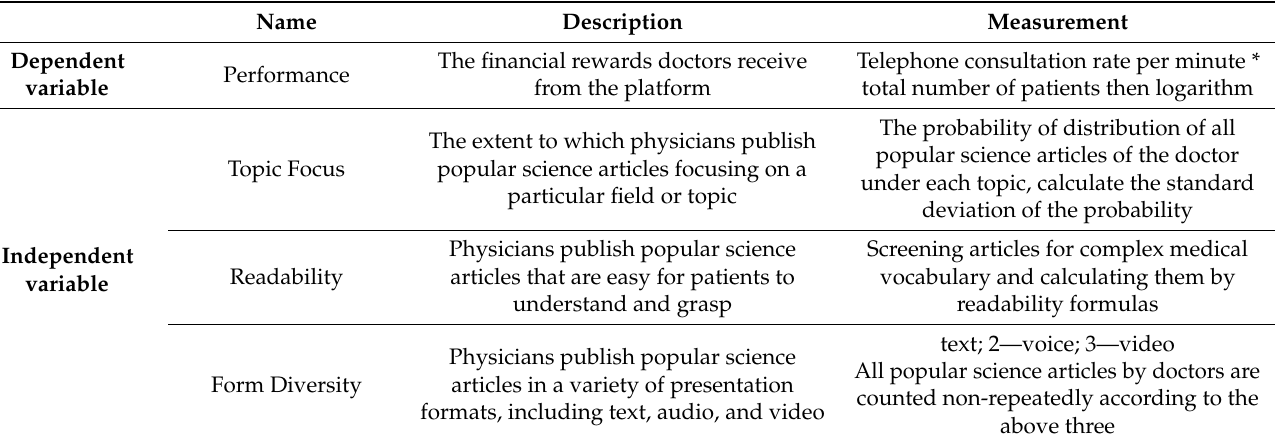
Table 1. Variable Description and